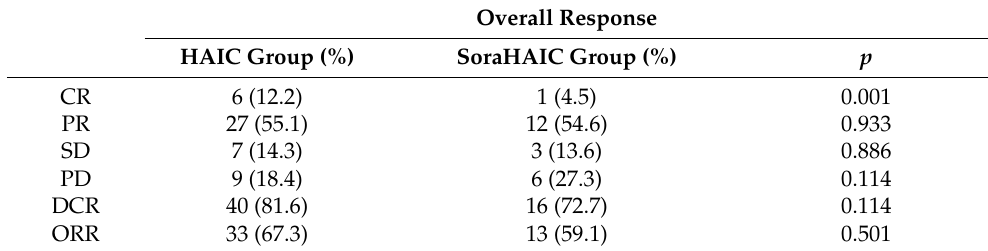
Table 2. Summary of best response based on the mRECIST criteria.